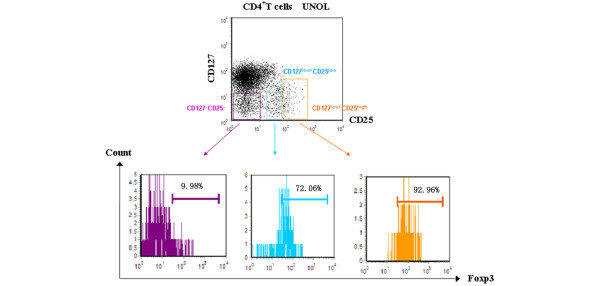
Expressions of Foxp3 in CD25high, CD25low, and CD25- subpopulations of CD4+ CD127low/- T cells from patients with untreated new-onset lupus (UNOL).